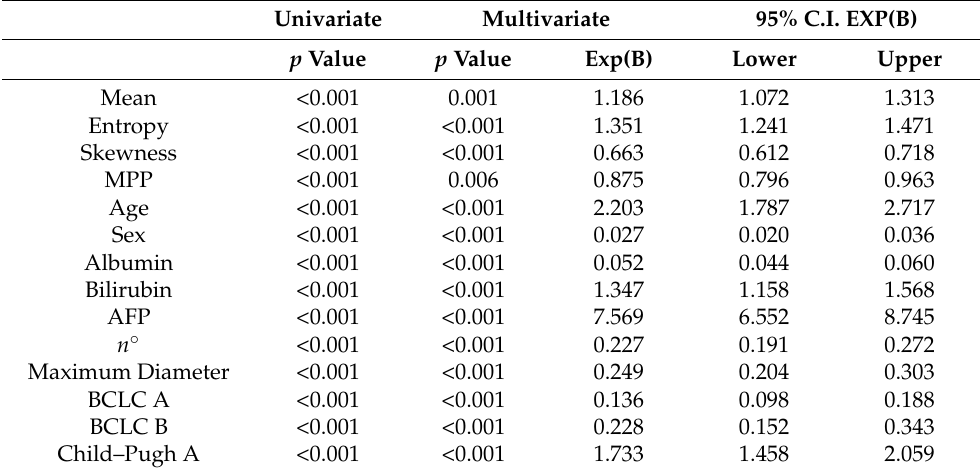
Table 8. Cox regression analysis—combined radiomic features and clinical variable association with